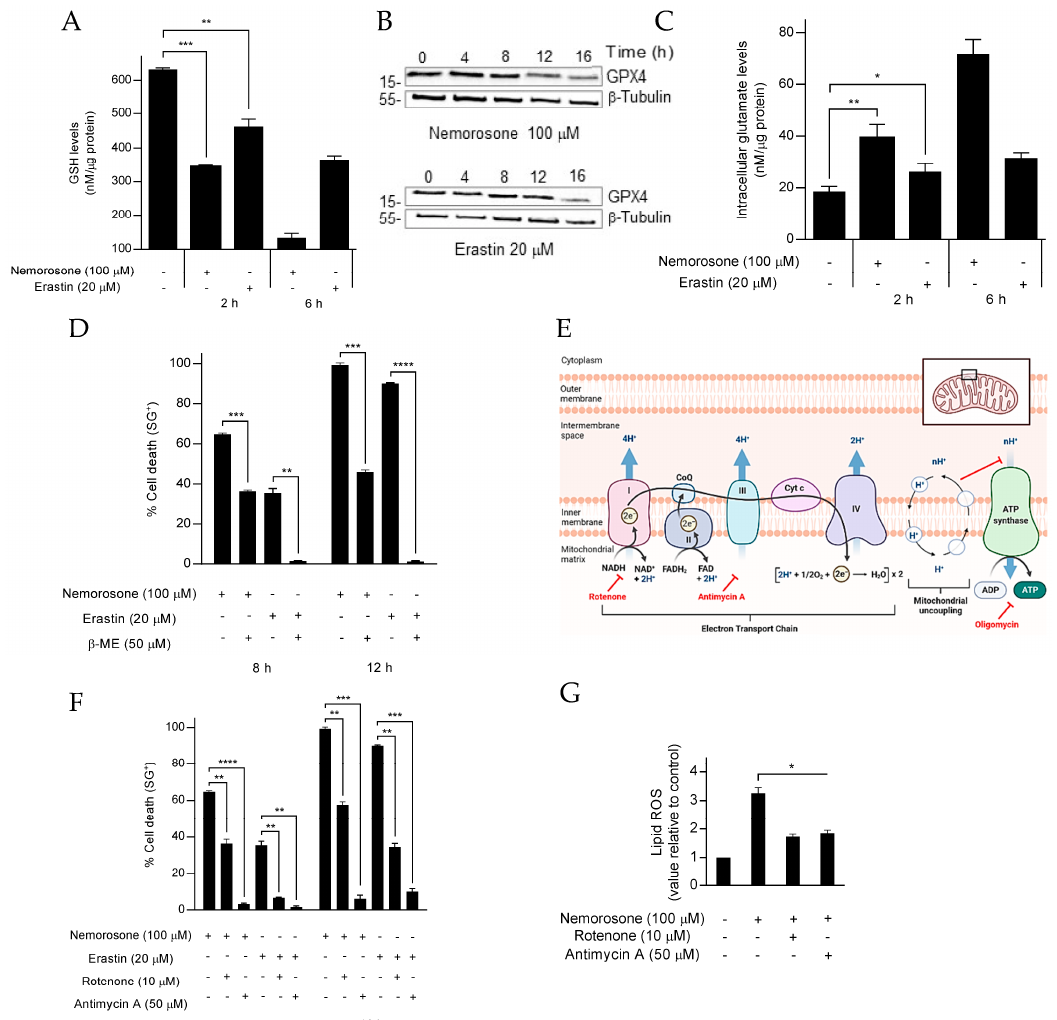
Figure 2. Nemorosone acts as a class I ferroptosis-inducing compound. ( A ) GSH levels in HT1080 cells treated with nemorosone (100 µ M) or erastin (20 µ M). ( B ) Western blot analysis of the expres- sion of GPX4 and β -tubulin in HT1080 cells after treatment with nemorosone (100 µ M) or erastin (20 µ M). ( C ) Intracellular glutamate levels in HT1080 cells treated with nemorosone (100 µ M) or erastin (20 µ M). ( D ) Percentage of cell death at different time points induced by nemorosone (100 µ M) or erastin (20 µ M) in HT1080 cells, assessed using SytoxGreen dye, in the absence or presence of β -mercaptoethanol ( β -ME, 50 µ M). ( E ) Schematic representation of some inhibitors of the mitochon- drial oxidative phosphorylation. Electrons from substrates pass through complexes I to IV of the electron transport chain. Protons (H + ) are pumped into the intermembrane space using the energy generated by this process. The resulting proton gradient is used to drive ATP synthesis. This figure was created with BioRender.com (accessed on 17 July 2022). ( F ) Percentage of cell death induced by nemorosone (100 µ M) and erastin (20 µ M) in HT1080 cells, assessed using SytoxGreen dye, in absence or presence of the subsequent electron transport chain inhibitors: rotenone (10 µ M) and antimycin A (50 µ M). ( G ) Analysis using flow cytometry of the C11-BODIPY lipid peroxidation sensor in live HT1080 cells (DRAQ7-negative cells) following nemorosone treatment (100 µ M, 4 h). Electron transport chain inhibitors: rotenone (10 µ M) and antimycin A (50 µ M). All quantitative data are shown as mean ± SD from three separate experiments. * p < 0.05, ** p < 0.01, *** p < 0.001, **** p < 0.0001 determined by unpaired Student’s t